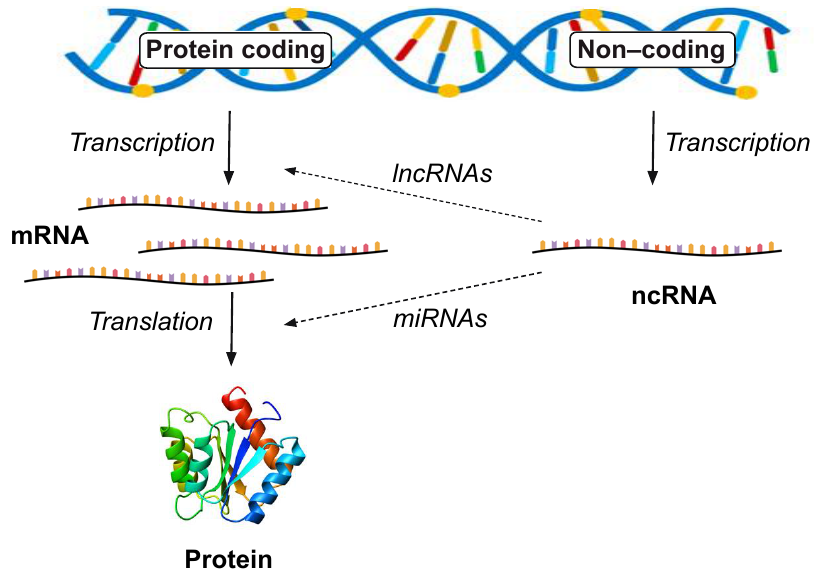
Figure 3. Long non-coding RNAs are novel modulators of transcription and lncRNA transcripts are thought to interfere with the expression of protein coding genes at the transcriptional level, whereas miRNAs are thought to silence the expression of genes at the translational level.